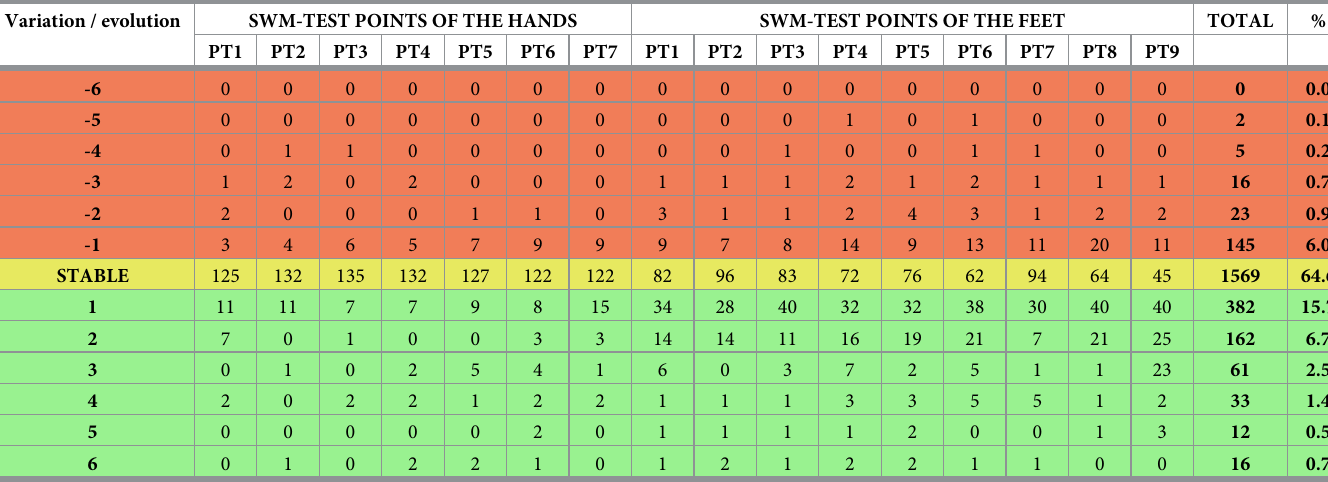
Table 4. Variation of the point-to-point evolution by SWM-test of the hands and feet at the end of the leprosy patient treatment in Jardino´polis (SP). Variation / evolution SWM-TEST POINTS OF THE HANDS